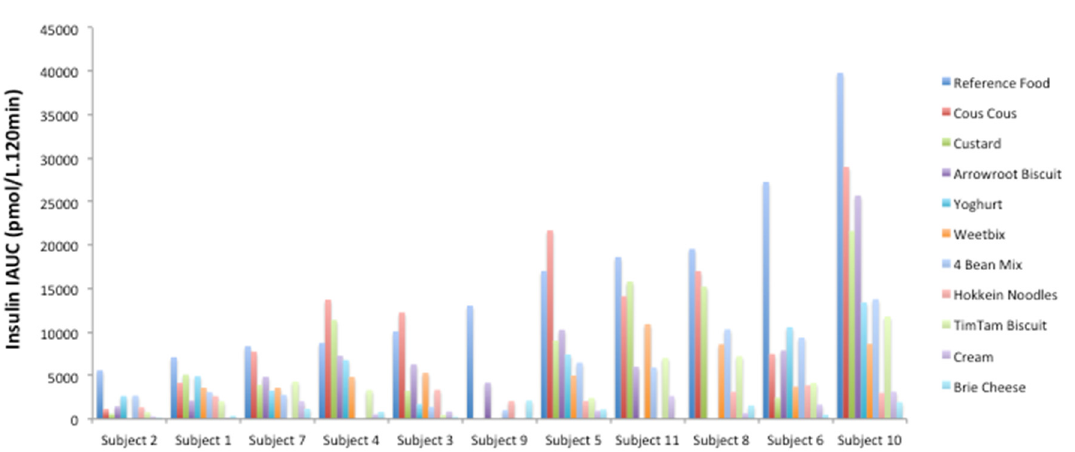
Figure 1. Within-individual insulin responses to 1000 kJ portions of the reference food (glucose) compared to 1000 kJ portions of the test foods over 120 min.